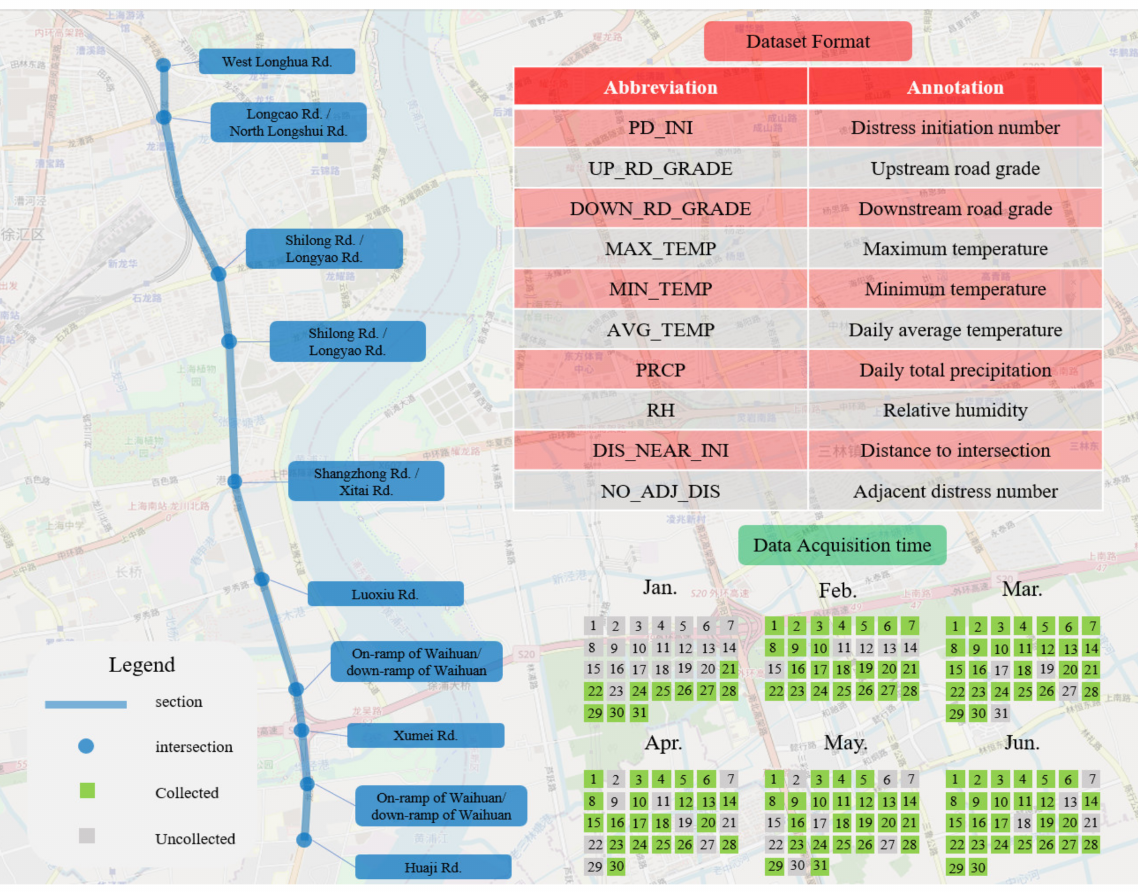
Figure 2. Overview of the study area, time period, and distress initiation dataset